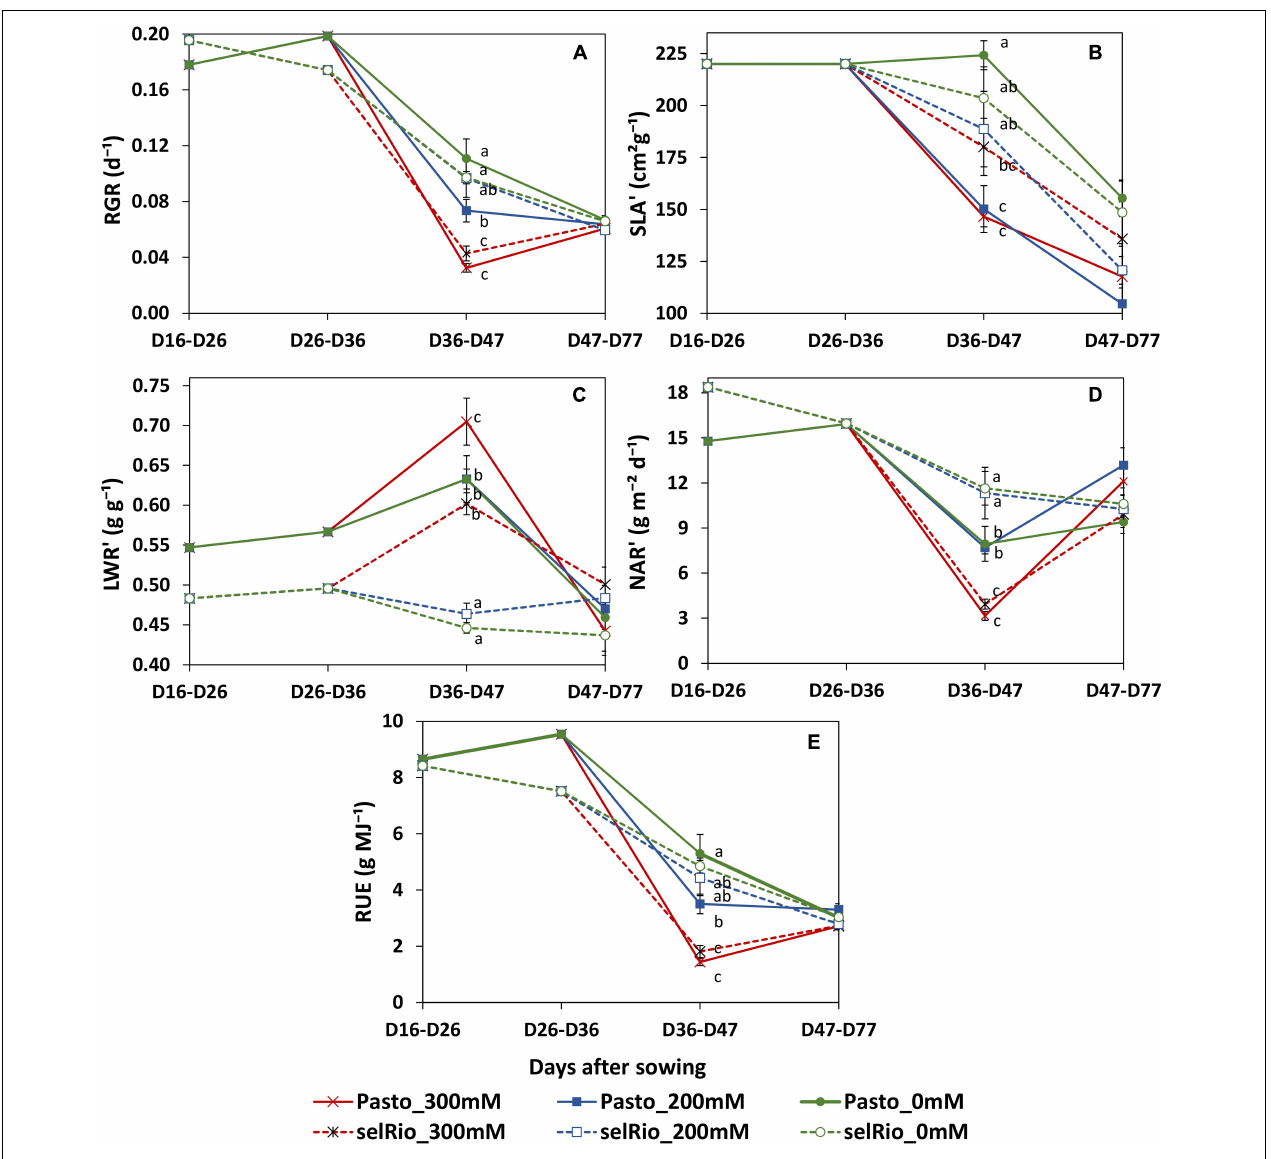
FIGURE 8 | Relative growth components of quinoa throughout the growing period. (A) Relative growth rate (RGR). (B) Incremental specific leaf area (SLA’). (C) Incremental leaf weight ratio (LWR’). (D) Incremental net assimilation rate (NAR’). (E) Radiation use efficiency estimated by LINTUL mechanistic model. Means of 4 plants. Error bars indicate SE of individual means. Statistically significant differences ( p ≤ 0.05) between any variety and salt treatment combination are shown with different